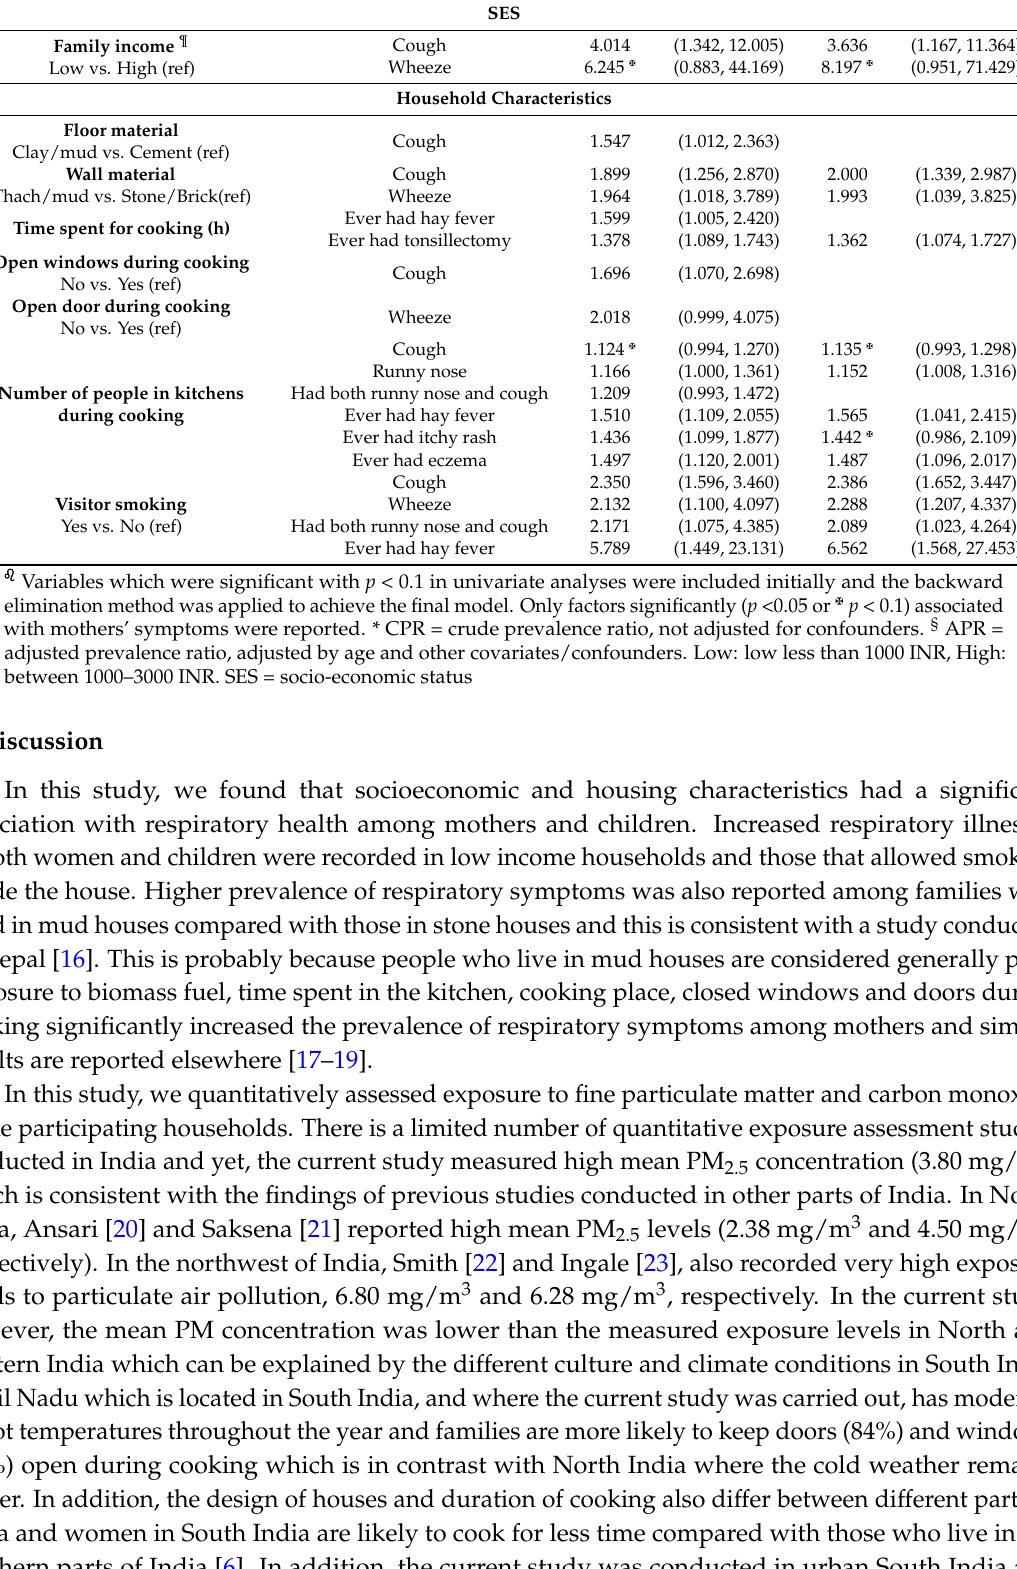
Table 5. Association between socioeconomic status, kitchen characteristics, occupant activities, and prevalence of children’s respiratory symptoms. Table 4. Association between socioeconomic status, household characteristics, occupant activities, and prevalence of respiratory symptoms among mothers. Factor  Symptom CPR * 95% CI APR § 95% CI SES Indicators